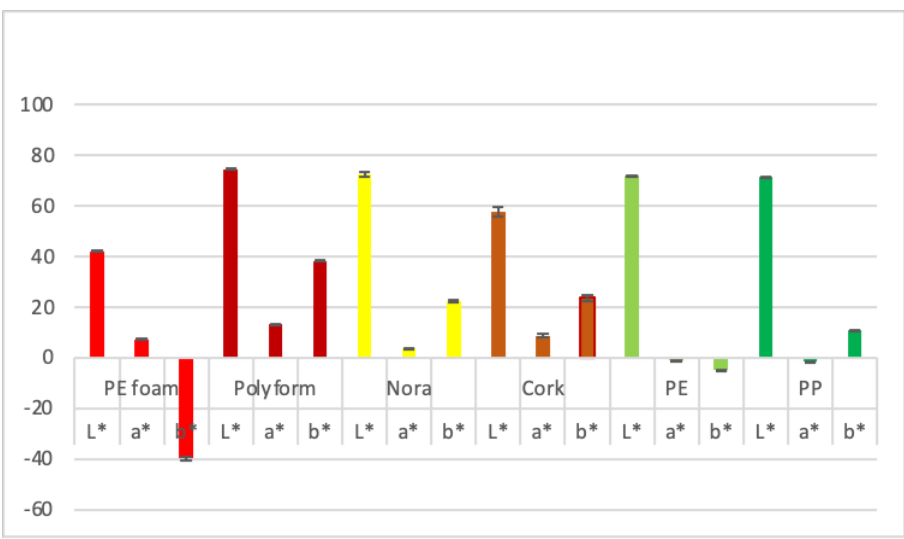
Figure 7. CIE color L*, a* b* parameters of material surfaces. Polyform and PEfoam orthotic materials have the highest colorfulness as demon- strated by higher C*ab values (40.5), see Figure 8. Significantly lower colorfulness values were recorded for cork and Nora materials, 25.2 and 22.7 respectively. PP and PE have the lowest colorfulness 11.0 and 4.9 respectively. With regard to h ◦ measurements, all values amount to around zero, a threshold that signifies red color. Slightly positive h ◦ values ranged from 1.2 to 1.4 for cork, PE, Nora and Polyform orthotic material. PP and PEfoam have slightly negative values ( − 1.4). Besides being the lightest and the yellowish, Polyform was also among the most saturated in color, hence more colorful, as compared to other materials.